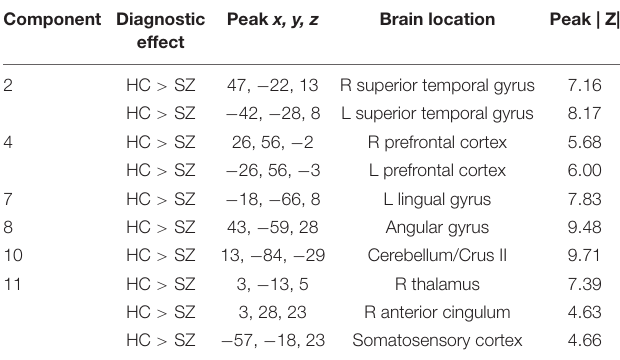
TABLE 4 | Brain labels and peak scores for volume ICA components showing diagnostic differences.